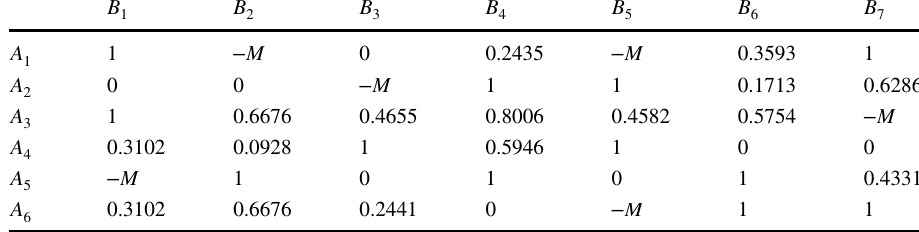
Table 9 Perceived value matrix H = ( h ) 6 ij ×